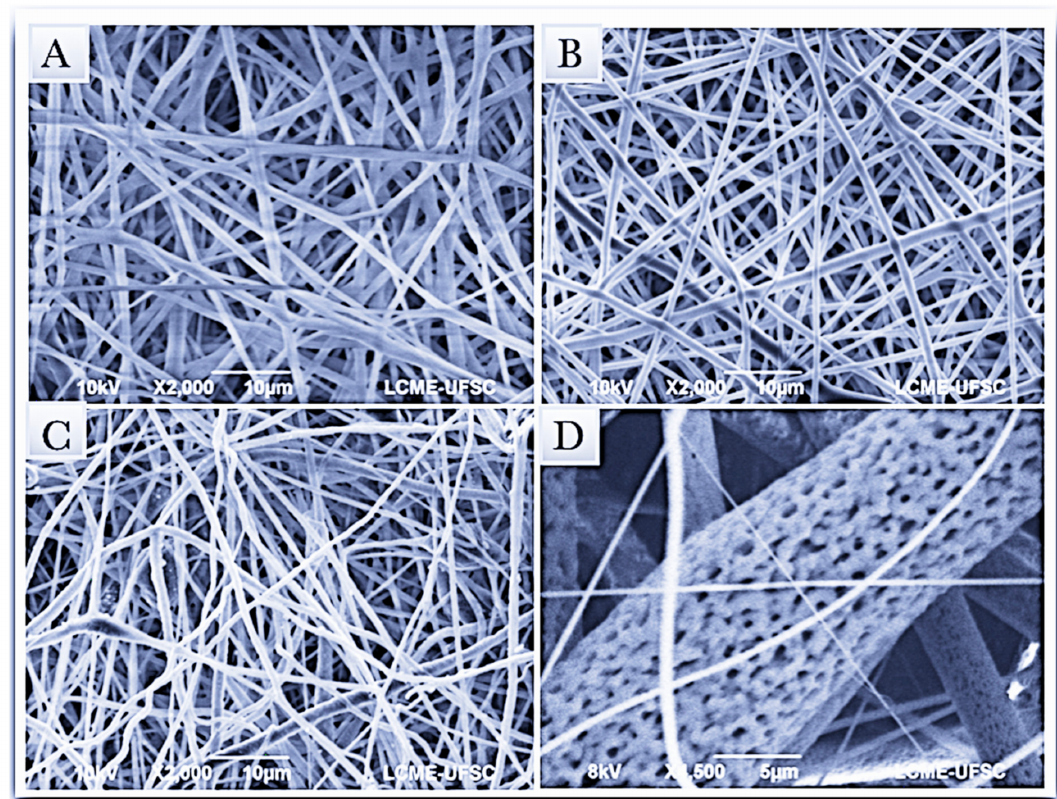
Figure 2. Scanning Electron Micrographs (SEM) of the electrospun membranes ( A ) Electrospun PLGA loaded with tea tree essential oil, ( B ) Electrospun PLGA loaded with furanone, ( C ) Electrospun pure PLGA. ( D ) Porous surface of the electrospun fibers.